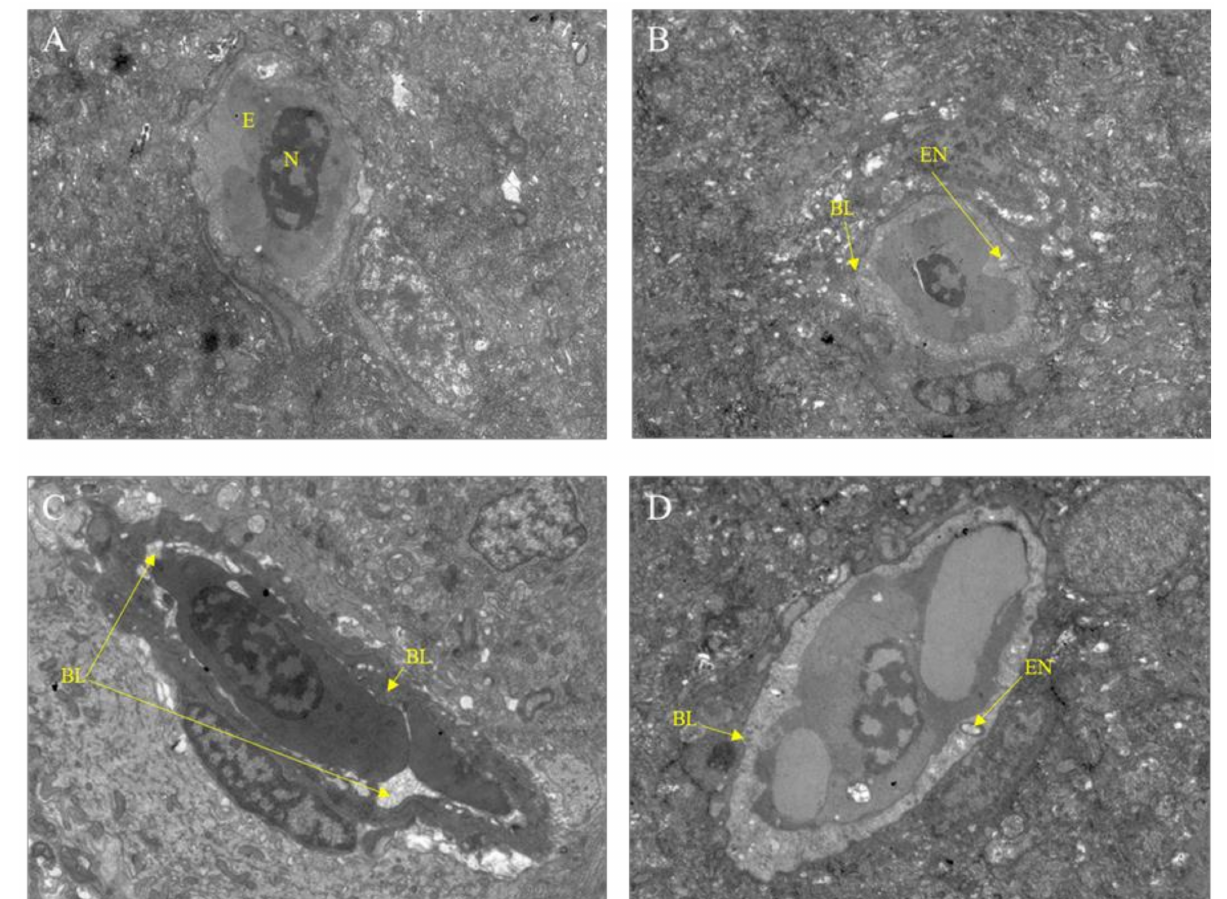
Figure 3. Transmission electron microscope observation of fish brain after exposure to Pb 2+ , M8OI, or mixture of Pb 2+ and M8OI for 28 d (scale bars = 5.0 µ m). ( A ) Control group; ( B ) Pb 2+ group; ( C ) M8OI group; ( D ) MIX group. Note: E, red blood cells; N, cell nucleus; EN, endothelial cell vacuole; BL, basement membrane.